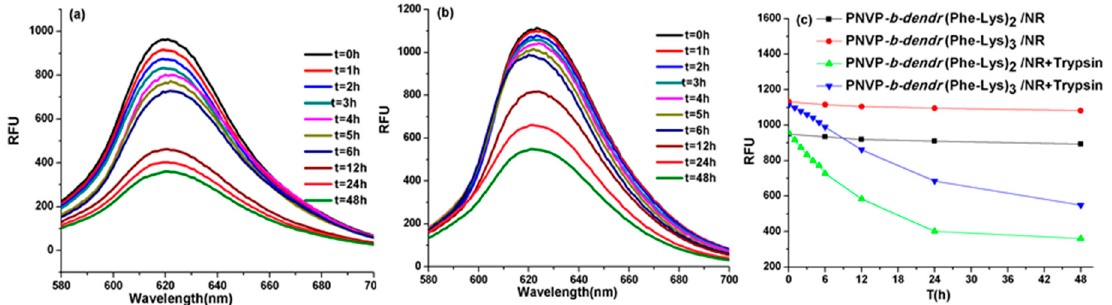
Figure 5. Fluorescence spectra of Nile red in PNVP -b-dendr (Phe-Lys) 2 ( a ) and PNVP -b-dendr (Phe-Lys) 3 ( b ) micelles after the incubation with trypsin, and effect of adding trypsin on the release rate of Nile Red ( c ).